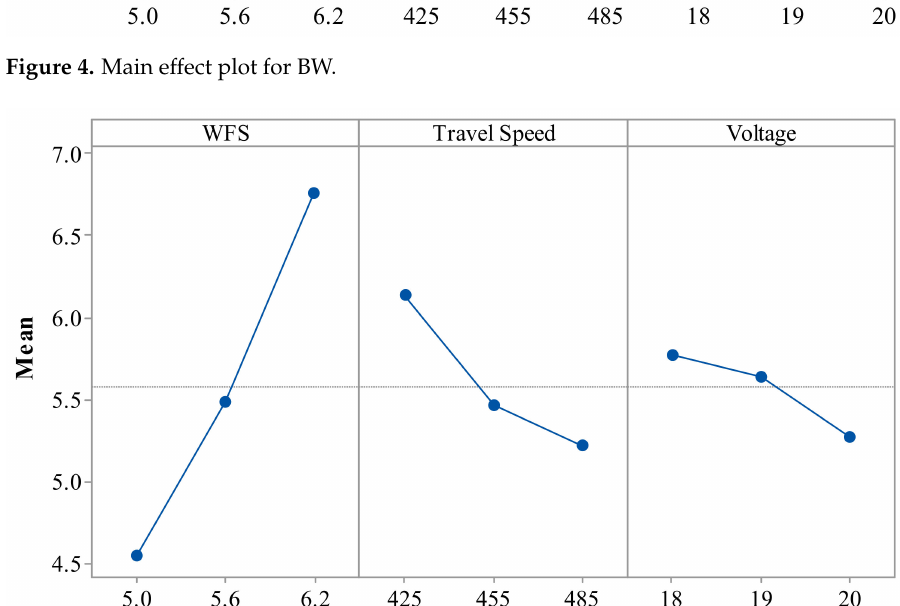
Figure 5. Main effect plot for